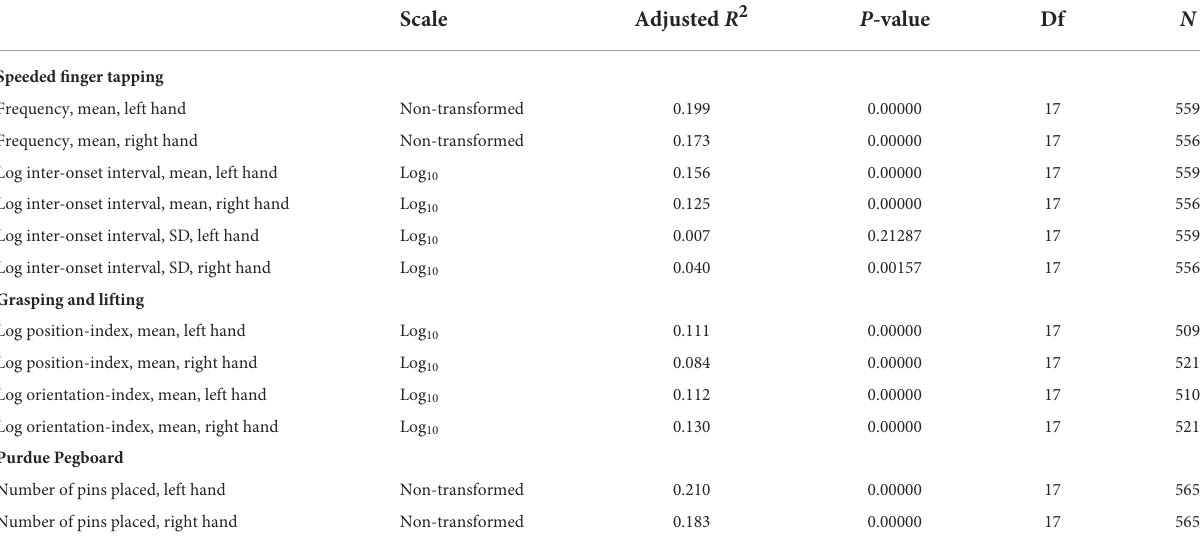
TABLE 7 Model 2 quality